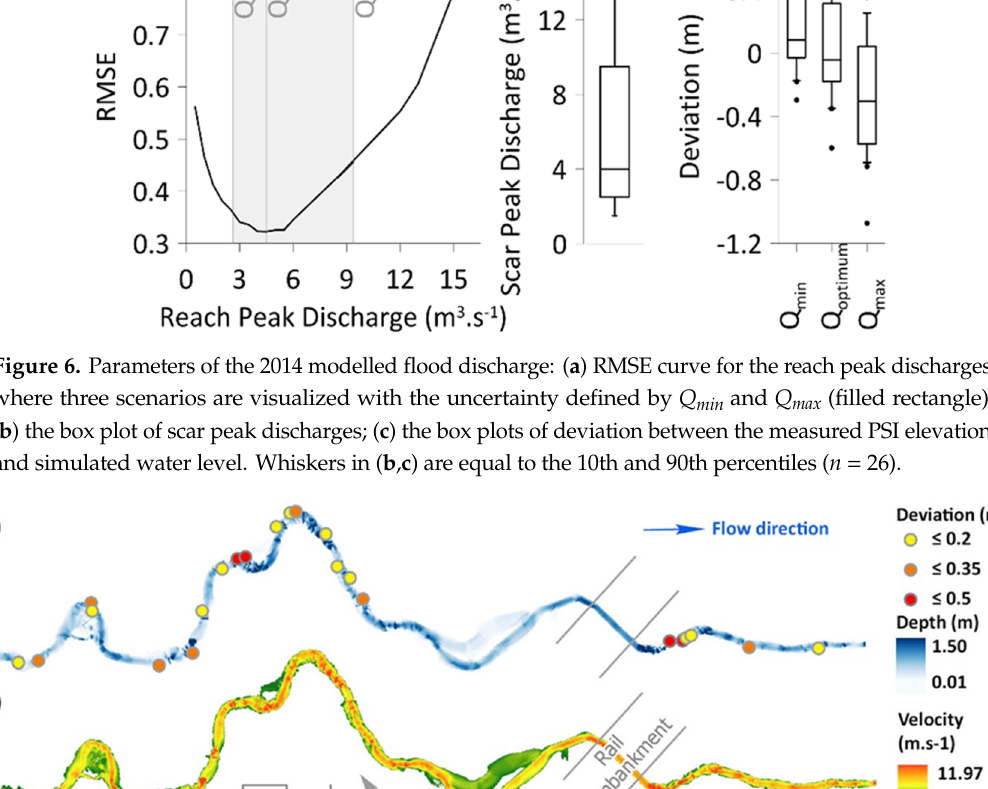
Figure 8. Plot describing the relationships between the flow velocity and absolute deviation of the PSI for Q optimum scenario.